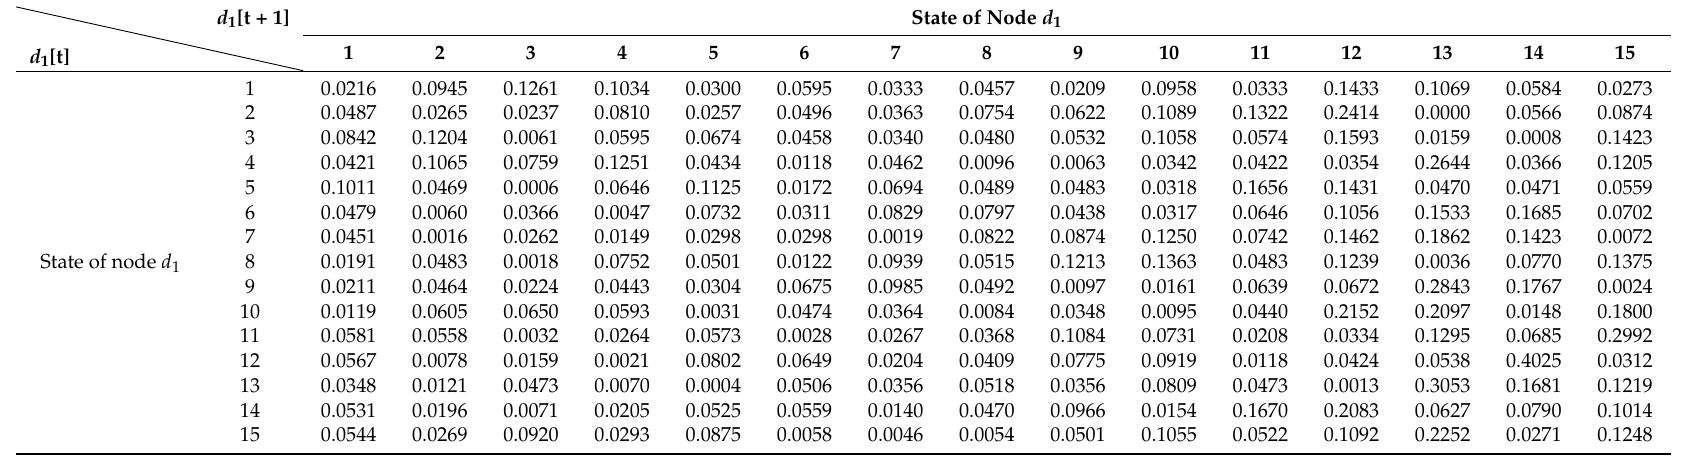
Table A1. Transition probability of DBN (Take d 1 as an